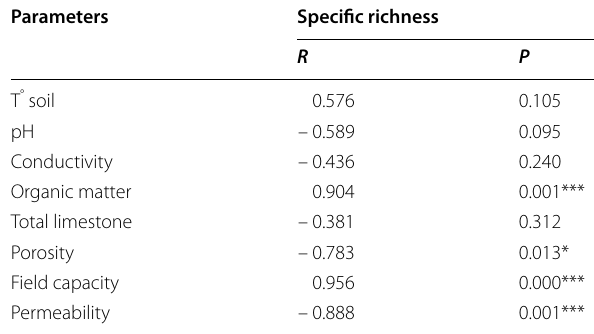
specific richness collected in the three study sites with the physicochemical soil characteristics (R: correlation coefficient; P significant at p <